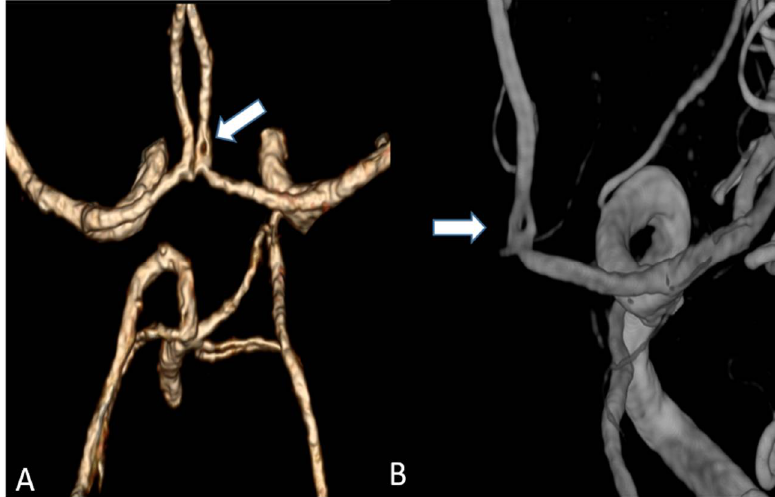
Figure 5. ( A ) Volume rendering of an anterior cerebral artery fenestration acquired by an UHR-CT ( B ) Three-dimensional (3D) digital subtraction angiography (DSA) to confirm arterial fenestration in (A), which is often not detected by normal resolution CTAs.